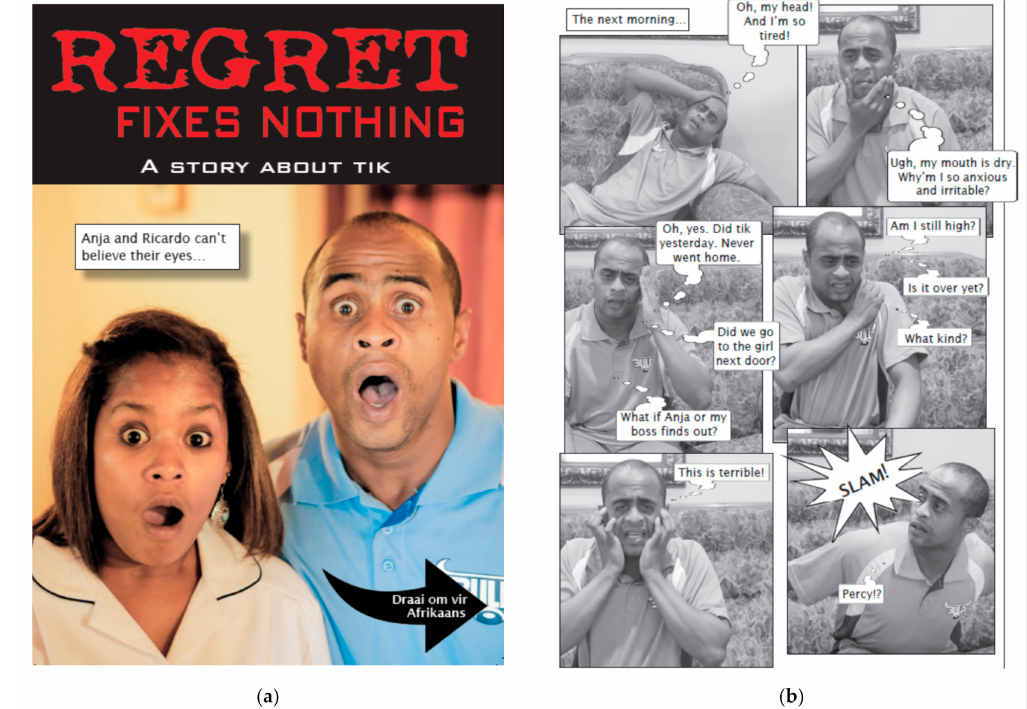
Figure 1. Cover page (panel ( a )) and an example page (panel ( b )) of the fotonovela version in English (in this study, only the Afrikaans version was used). As mentioned earlier, the street name for MA in South Africa is